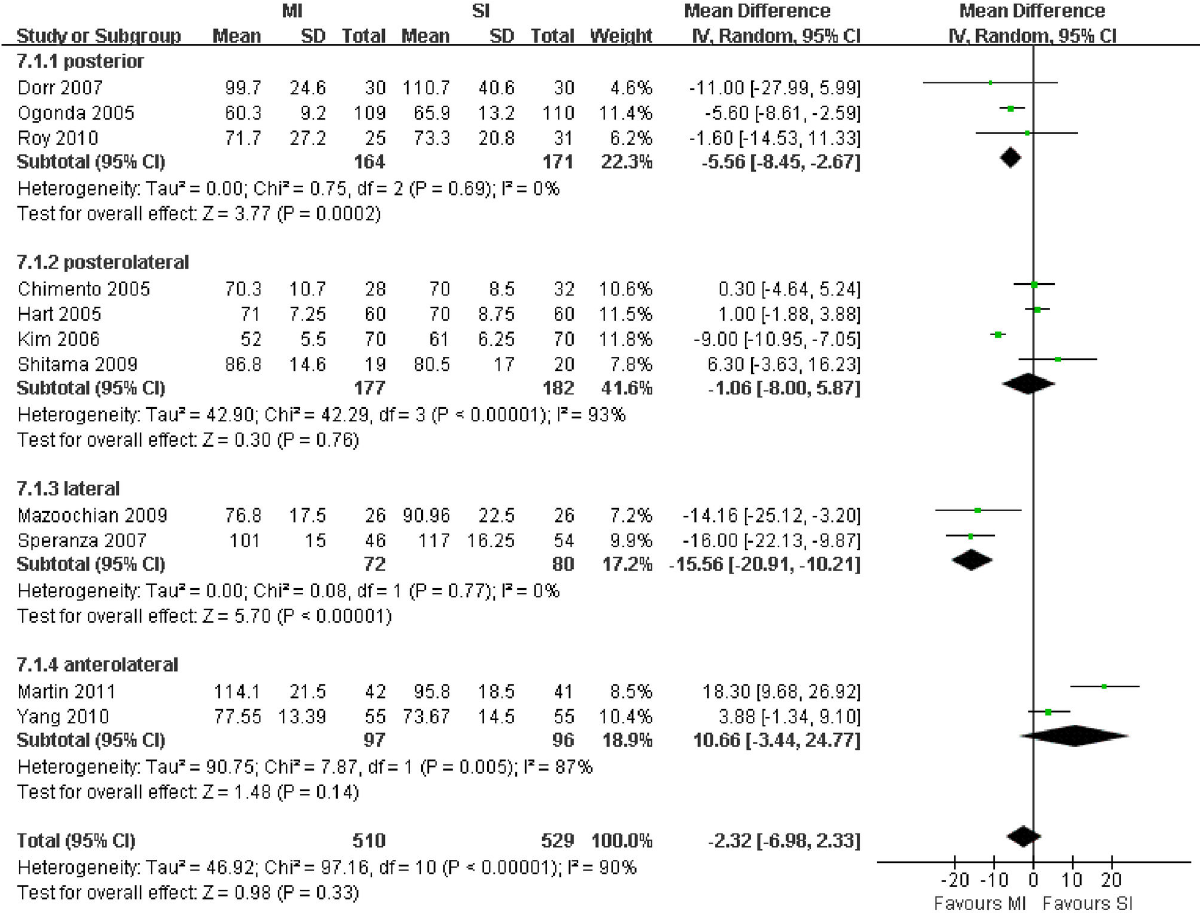
Figure 3. Meta-analysis of randomized controlled trials evaluating surgical duration. doi: